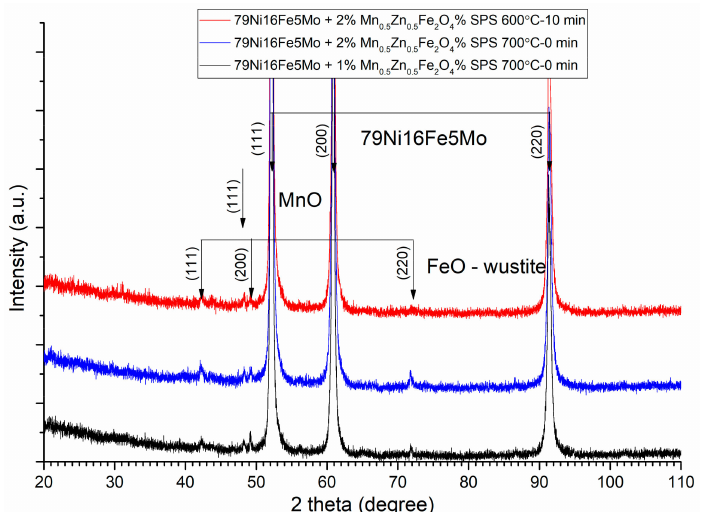
Figure 11. XRD patterns of the supermalloy/Mn 0.5 Zn 0.5 Fe 2 O 4 composite compacts with 1 and 2 wt.% of MnZn ferrite obtained by SPS at sintering temperatures of 600 and 700 ◦ C and sintering time of 0 min and 10 min. For clarity, the XRD patterns have been shifted